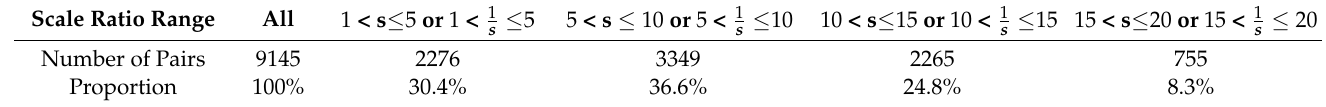
Table 1. Virtual SCB